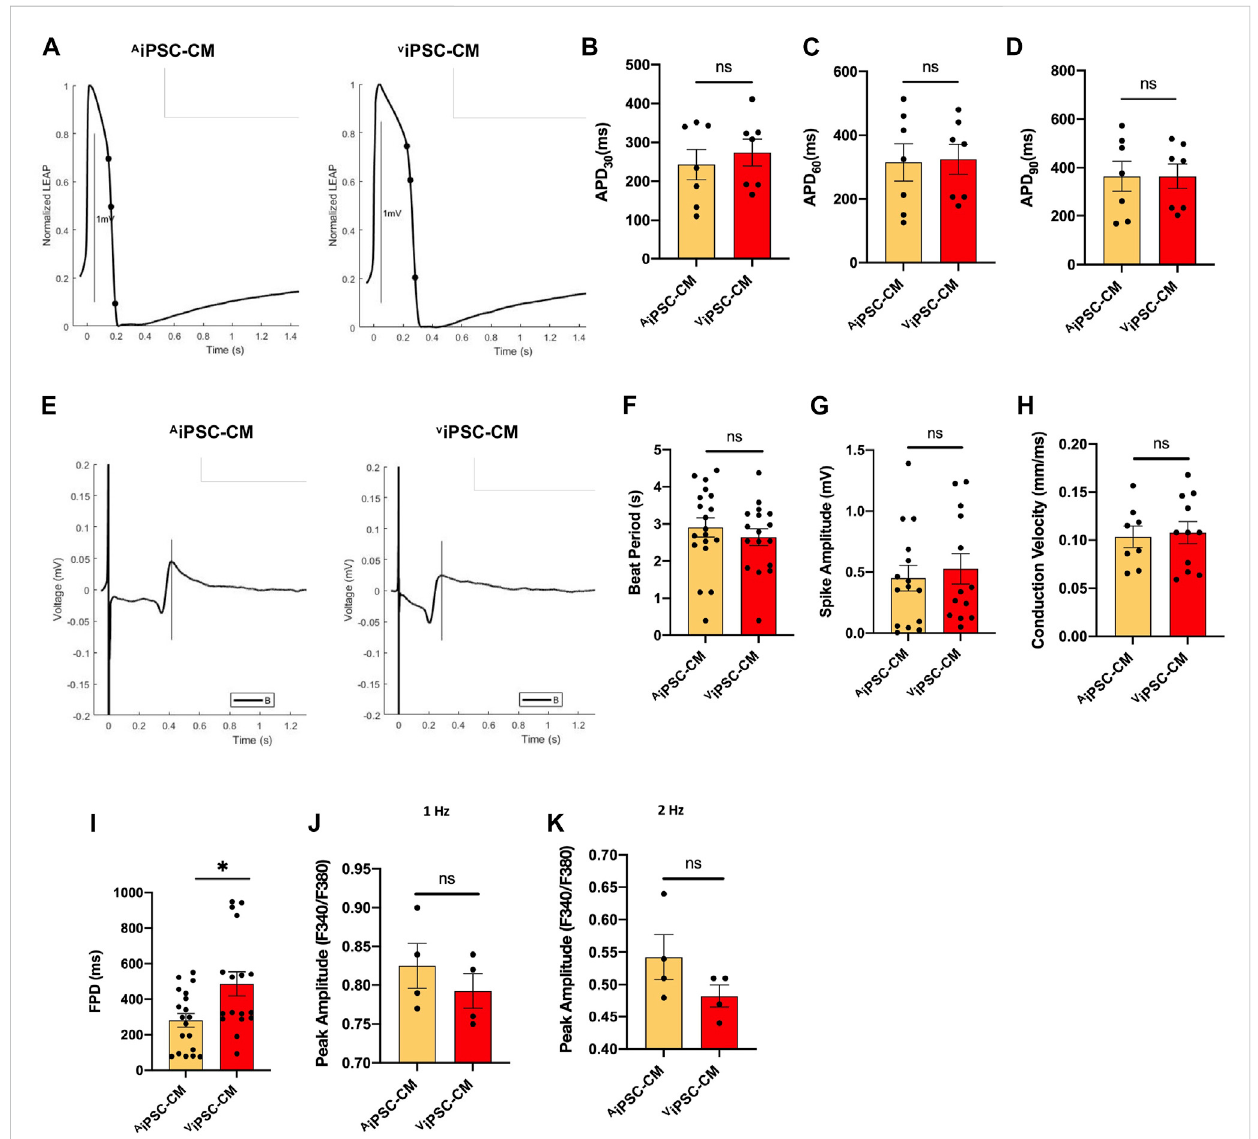
FIGURE 4 Electrophysiological properties of A iPSC-CM and V iPSC-CM were similar. (A) Representative action-potential and (E) fi eld-potential recording are displayed for A iPSC-CM and V iPSC-CM. (B – D) Action potential durations to 30% (APD 30 ), 60% (APD 60 ), and 90% (APD 90 ) recovery were calculated for A iPSC-CMand V iPSC-CM. (F – I) Fieldpotentialrecordingswereusedtocalculate (F) beatperiod, (G) spikeamplitude, (H) conductionvelocity,and (I) fi eld- potential duration (FPD) for A iPSC-CM and V iPSC-CM. (J,K) Peak Ca 2+ transient amplitudes were calculated from Fura-2 AM dye fl uorescence recordings in A iPSC-CM and V iPSC-CM while the cells were paced at 1 Hz and 2 Hz * p <